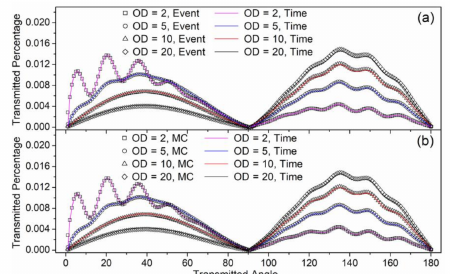
Figure 2. Total angular distribution of transmitted photons under different total optical depths (ODs). ( a ) Time-based model results compared with the scattering-based model results; ( b ) Time-based model results compared with the Monte Carlo simulation